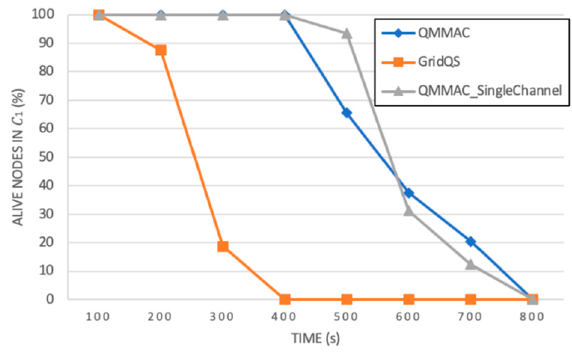
Figure 19. Alive nodes in C 1 .